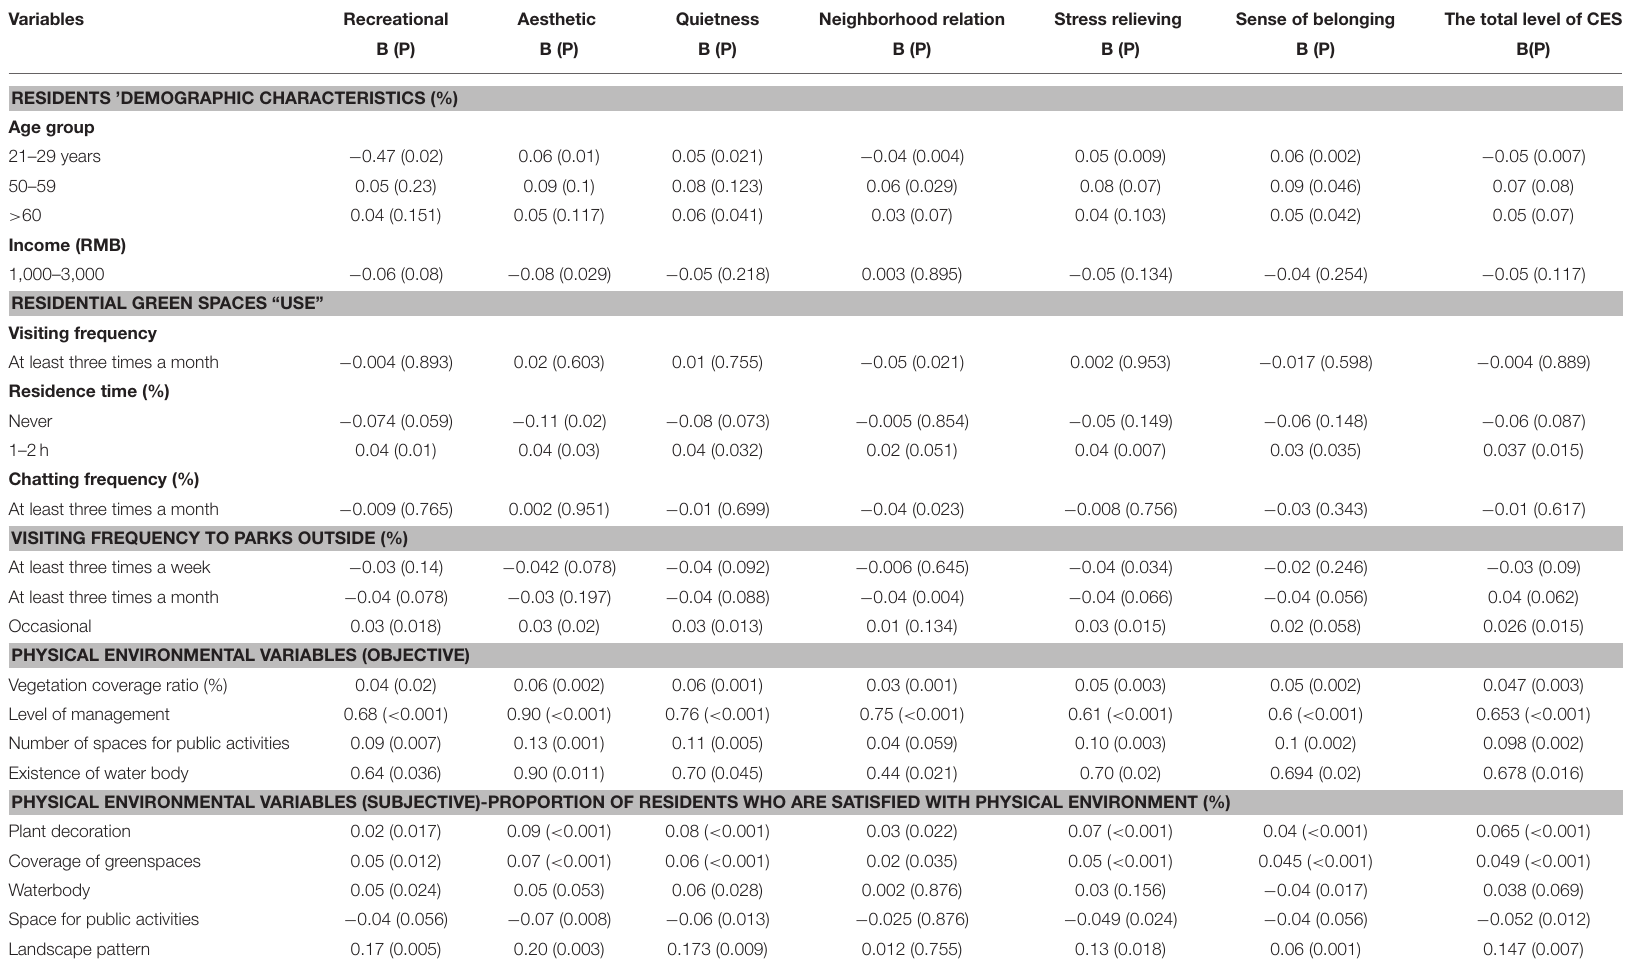
TABLE 4 | Relationship between residents’ satisfaction on different CES and demographic characteristics, use frequency of green spaces and variables of physical environment with the univariate linear regression